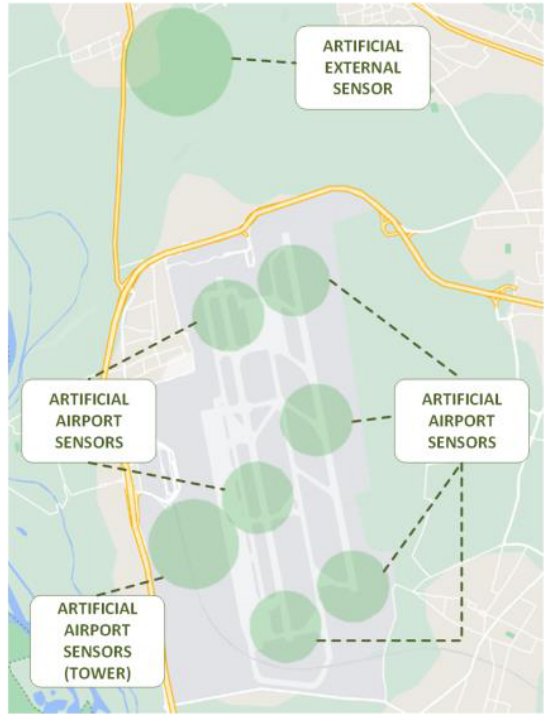
Figure 11. Displacement of counter-drone sensors for reference scenarios.